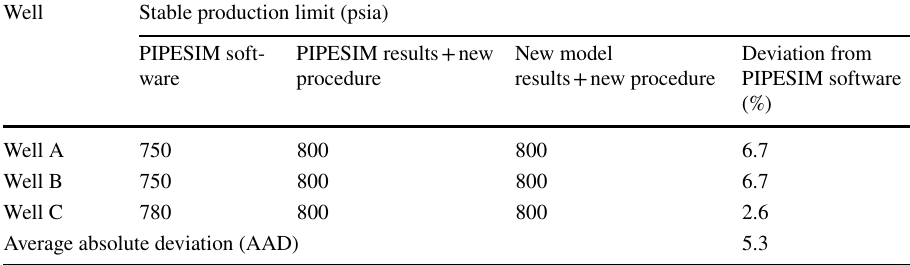
Table 2 Stable production limits from different models and methods for the example